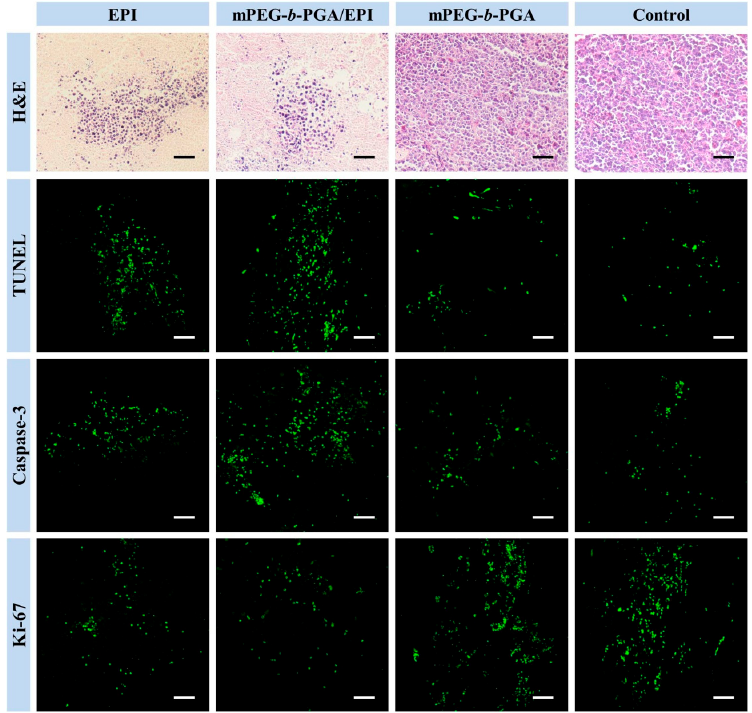
Figure 11. Histopathological ( i.e. , H&E), in situ cell apoptosis ( i.e. , TUNEL), and immunohistochemical analyses ( i.e. , cleaved caspase-3 and Ki-67) of tumor sections after treatment with free EPI, mPEG- b -PGA/EPI, mPEG- b -PGA, or NS as control. Scale bar: 50.0 μ m.